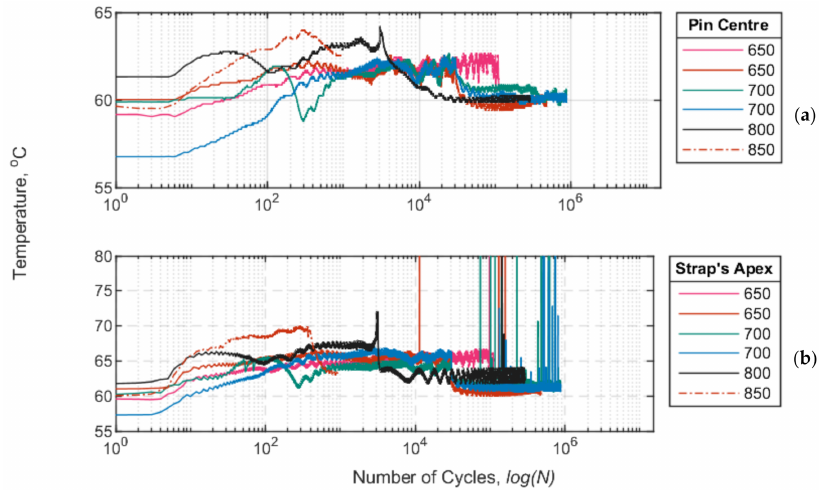
Figure 19. Temperature ( ◦ C) vs. number of cycles (logN) at the pin’s centre ( a ) and at the strap’s apex ( b ) for USLs between 650 and 850